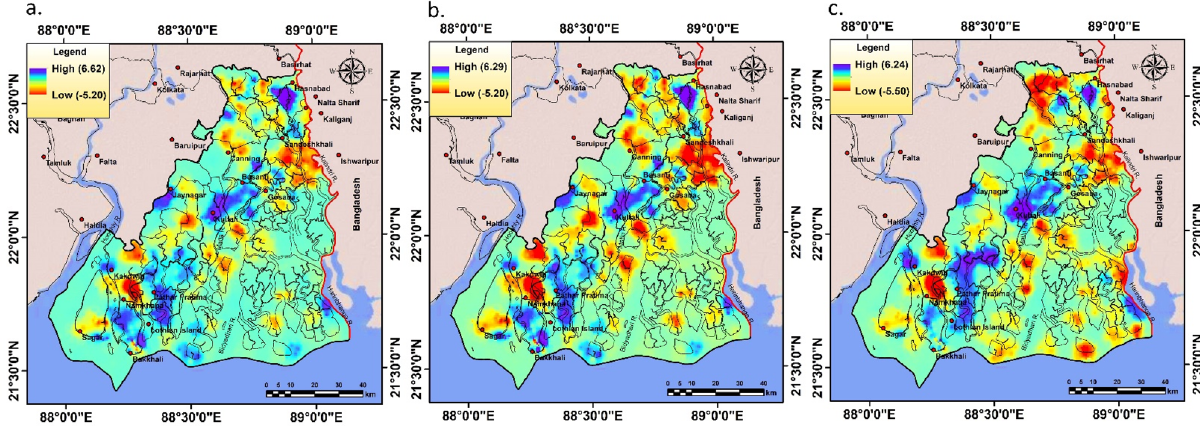
Figure 6. Identified changing ESVs hotspot and cold spot region in the study area within (1975–2020) using ( a ) C97a ( b ) D12 and ( c ) C97b unit values. The maps were prepared using ArcGIS 10.3 software [https:// deskt op. arcgis. com].